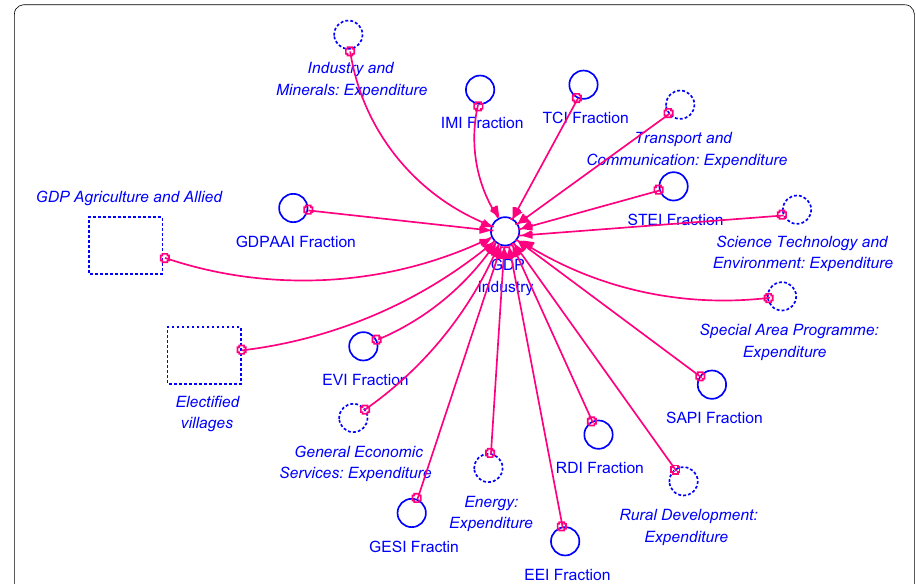
Fig. 7 Diagram showing system dynamics model for GDP from industrial